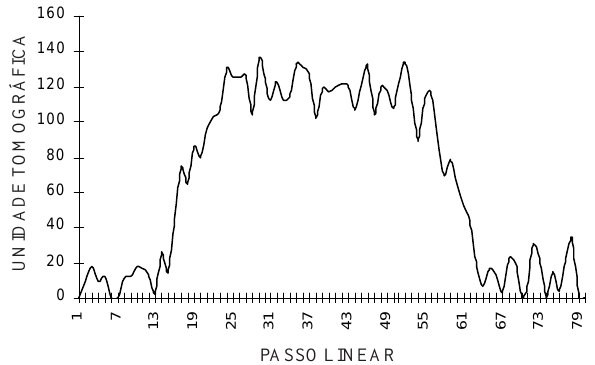
Figura 11. Variação das unidades tomográficas ao longo do transcepto L da figura